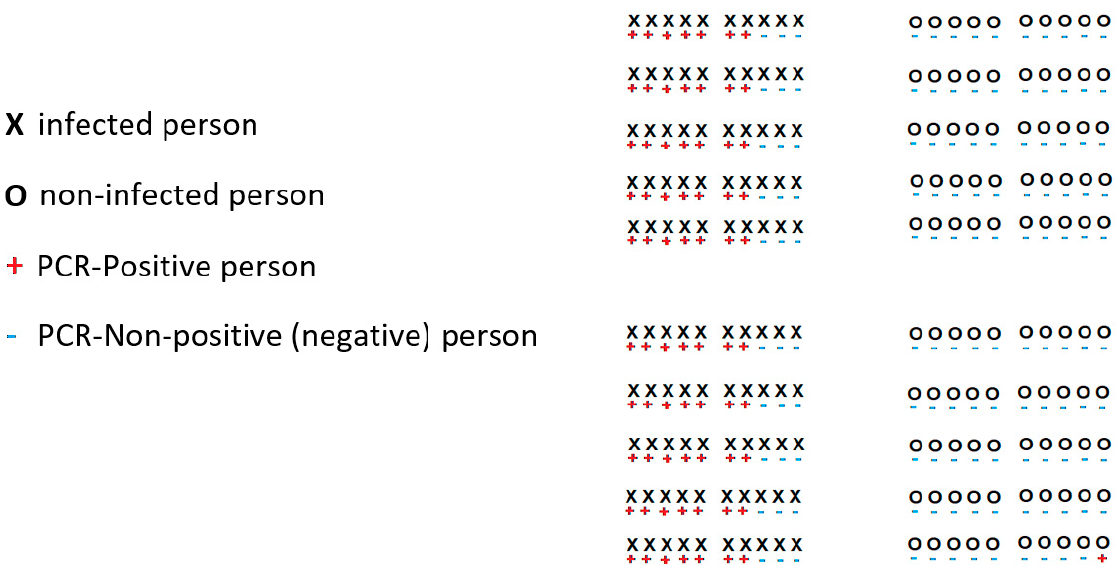
Figure 6. One hundred infected persons and one hundred non-infected persons. Seventy of the infected persons are PCR positive, and 99 of the non-infected persons are PCR negative. Thus, sensitivity is 70% and specificity is 99%.